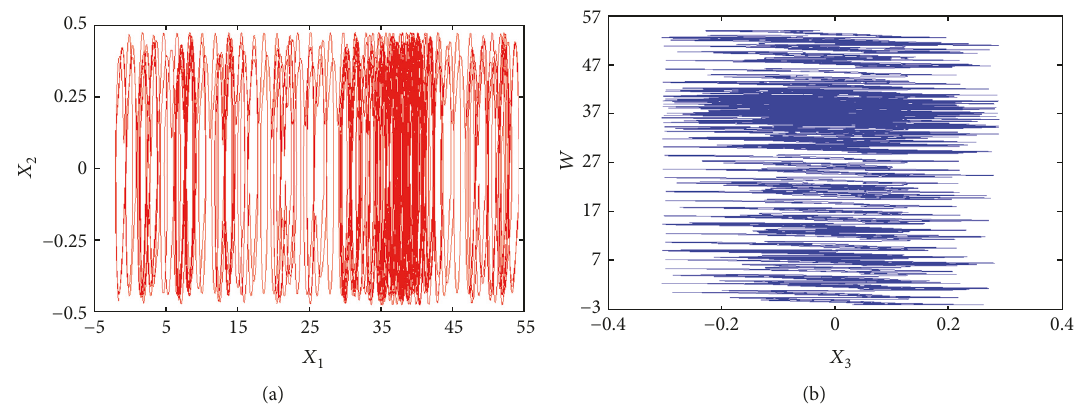
Figure 7: Divergent attractors of system (11) with a = 0.7, b = 10, 𝛿 1 = 𝛿 3 = 0, 𝛿 2 = 10 −6 , and 𝛿 4 = − 0.5. (a) Phase portrait in the X 1 - X 2 plane. (b) Phase portrait in the X 3 - W plane.